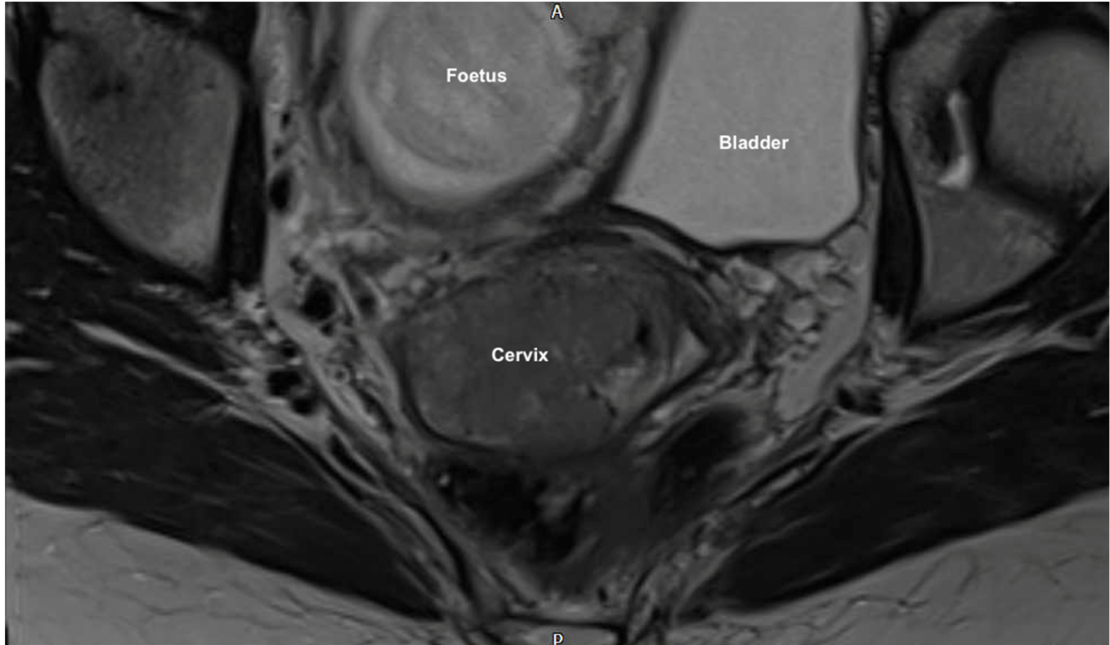
Figure 2. MRI coronal scan showing the large cervical mass (38 × 53 × 25 mm) centered on the ectocervix with probable parametrial extension. It fills the vaginal fornix and extends into the cervical canal